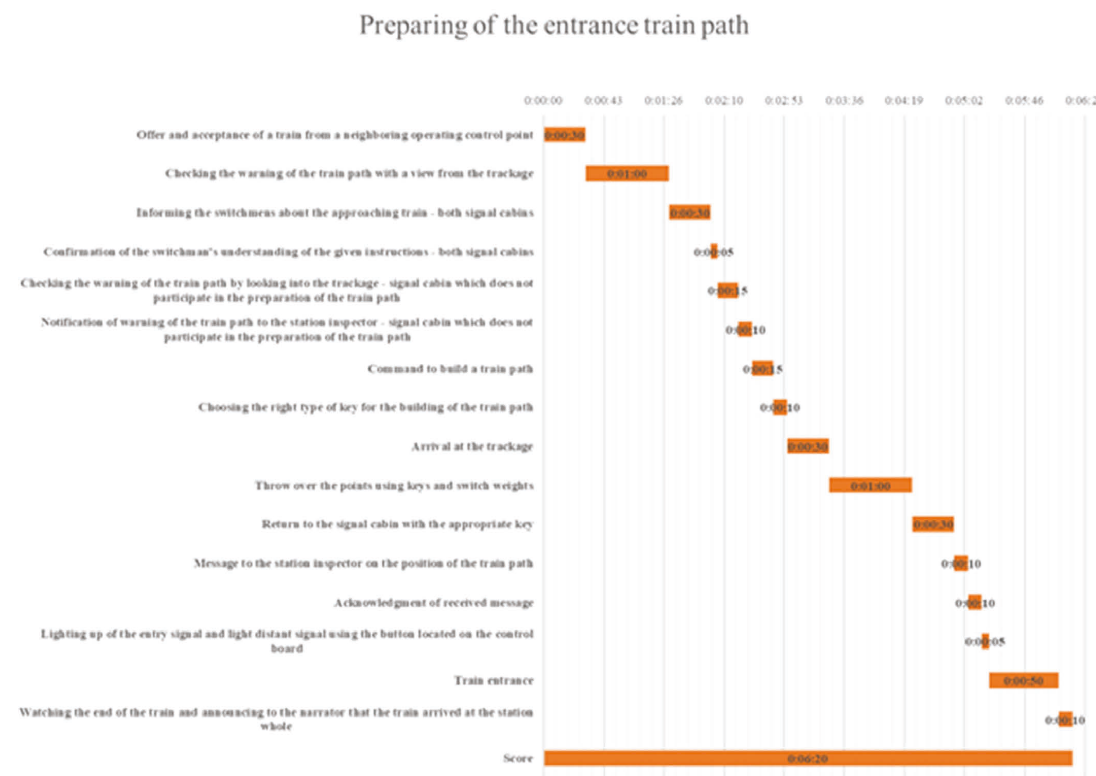
Figure 3: Preparing the entrance train path on the mechanical interlocking